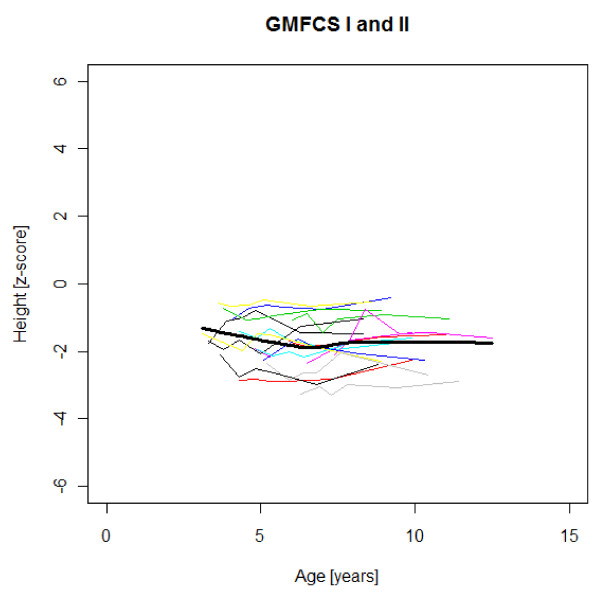
Height z-scores in GMFCS I-II. Height z-score at different age in 17 children with CP spastic diplegia, GMFCS I-II. Their mean z-score development with age is shown in black.